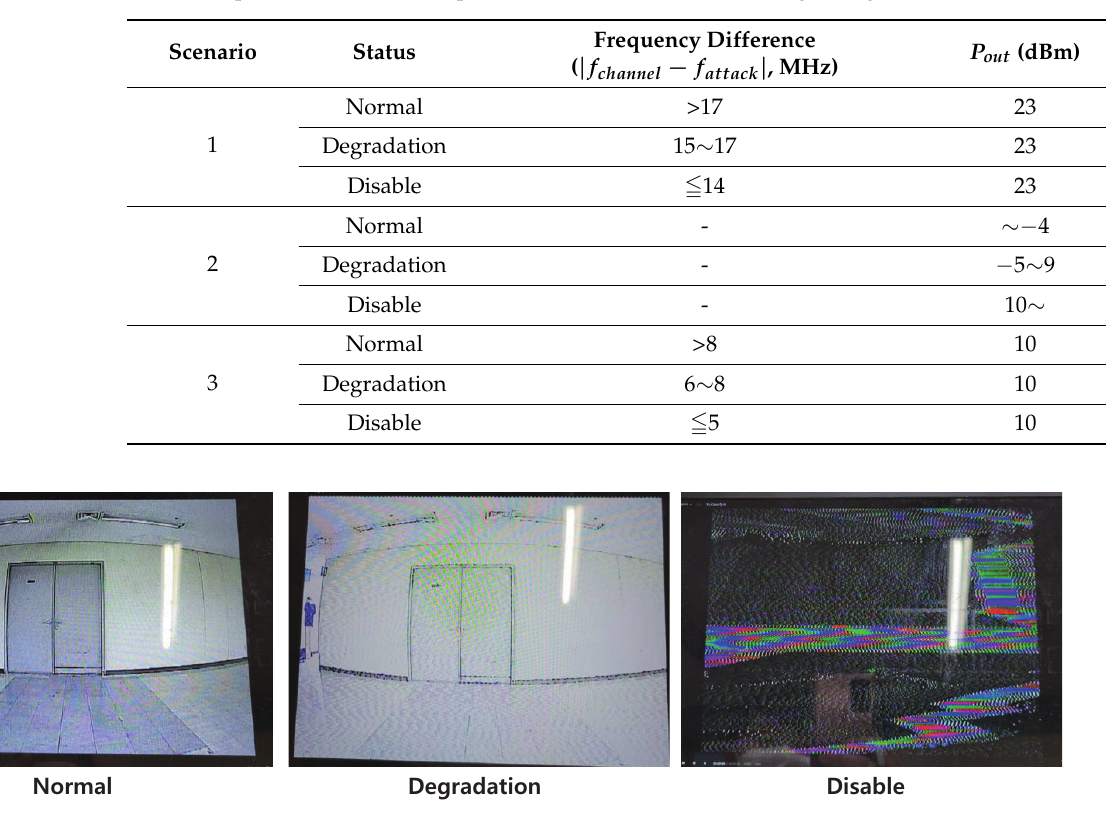
Figure 9. Examples of received videos in each